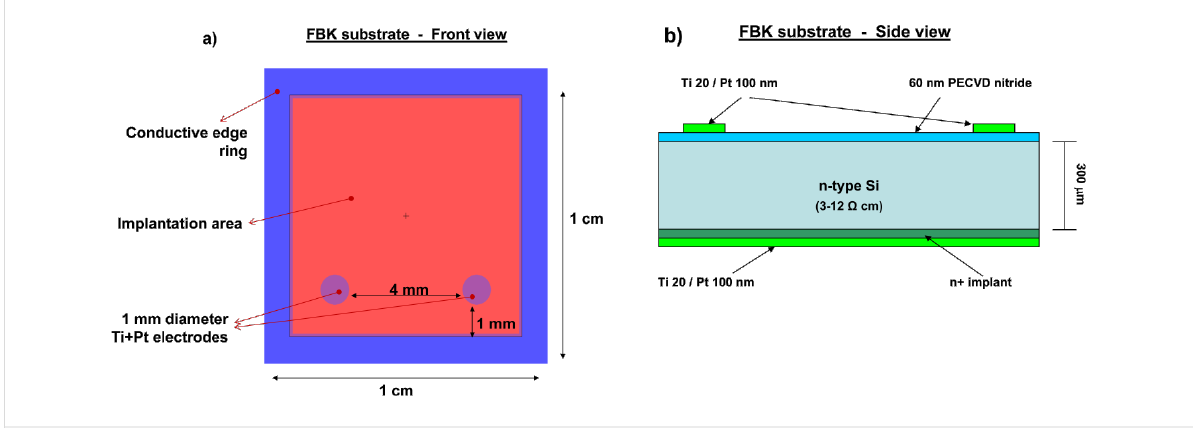
Figure 1: (a) Schematic front view and (b) side view of the Si substrate produced by Fondazione Bruno Kessler (FBK) in Povo, Trento